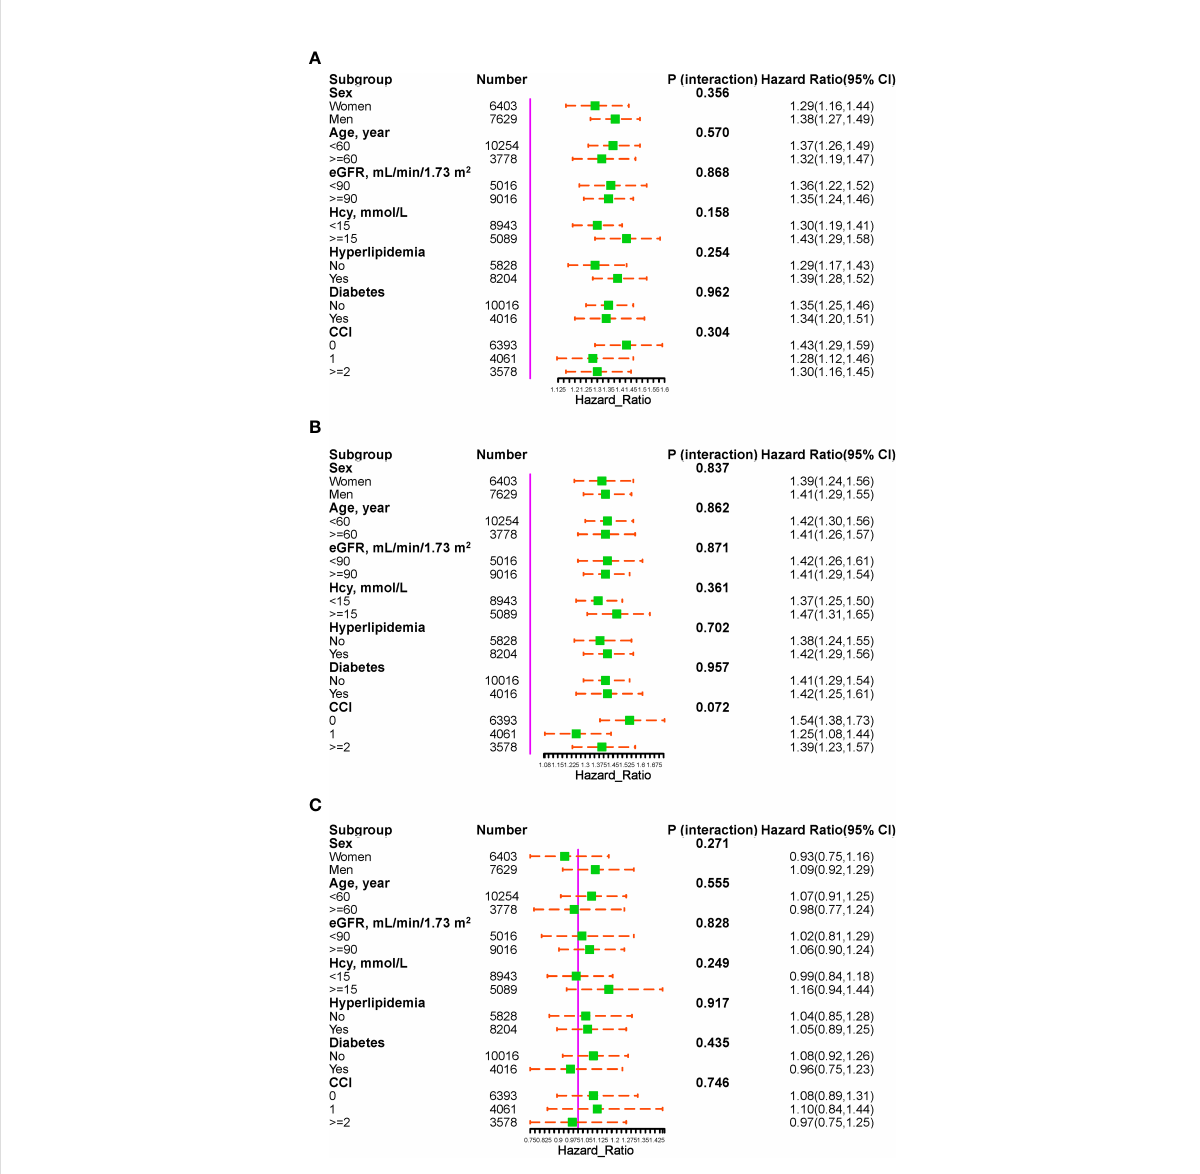
FIGURE 4 The association of METS-IR (per SD increment) with the risk of total stroke (A) , ischemic stroke (B) , and hemorrhagic stroke (C) in various